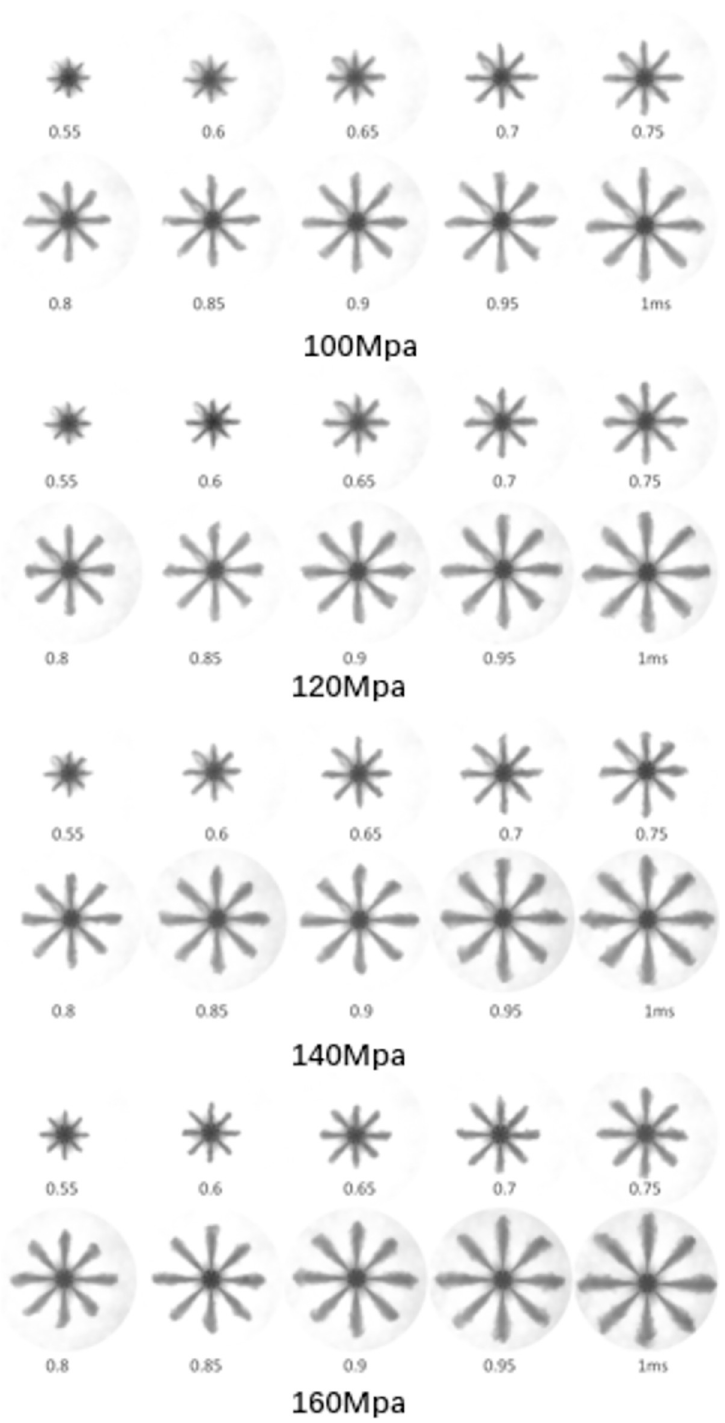
Fig 8. Spray morphology (time in ms ASOI) at various P in and fixed P out of 5MPa.